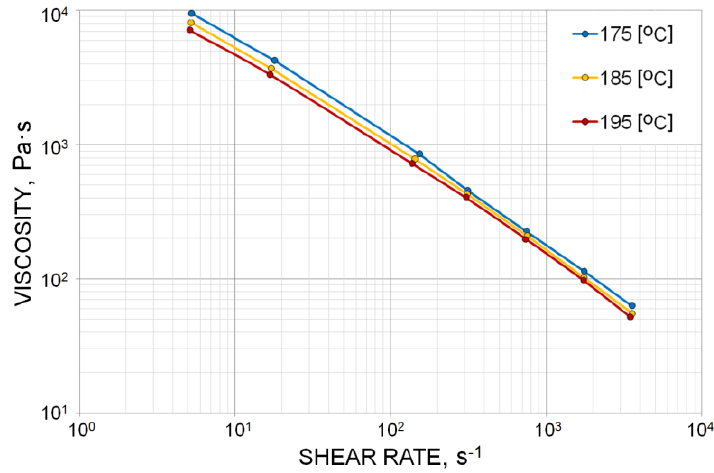
Figure 2. Viscosity curves of wood – plastic composite (WPC) 50/50 polypropylene (PP) copo inj 4.